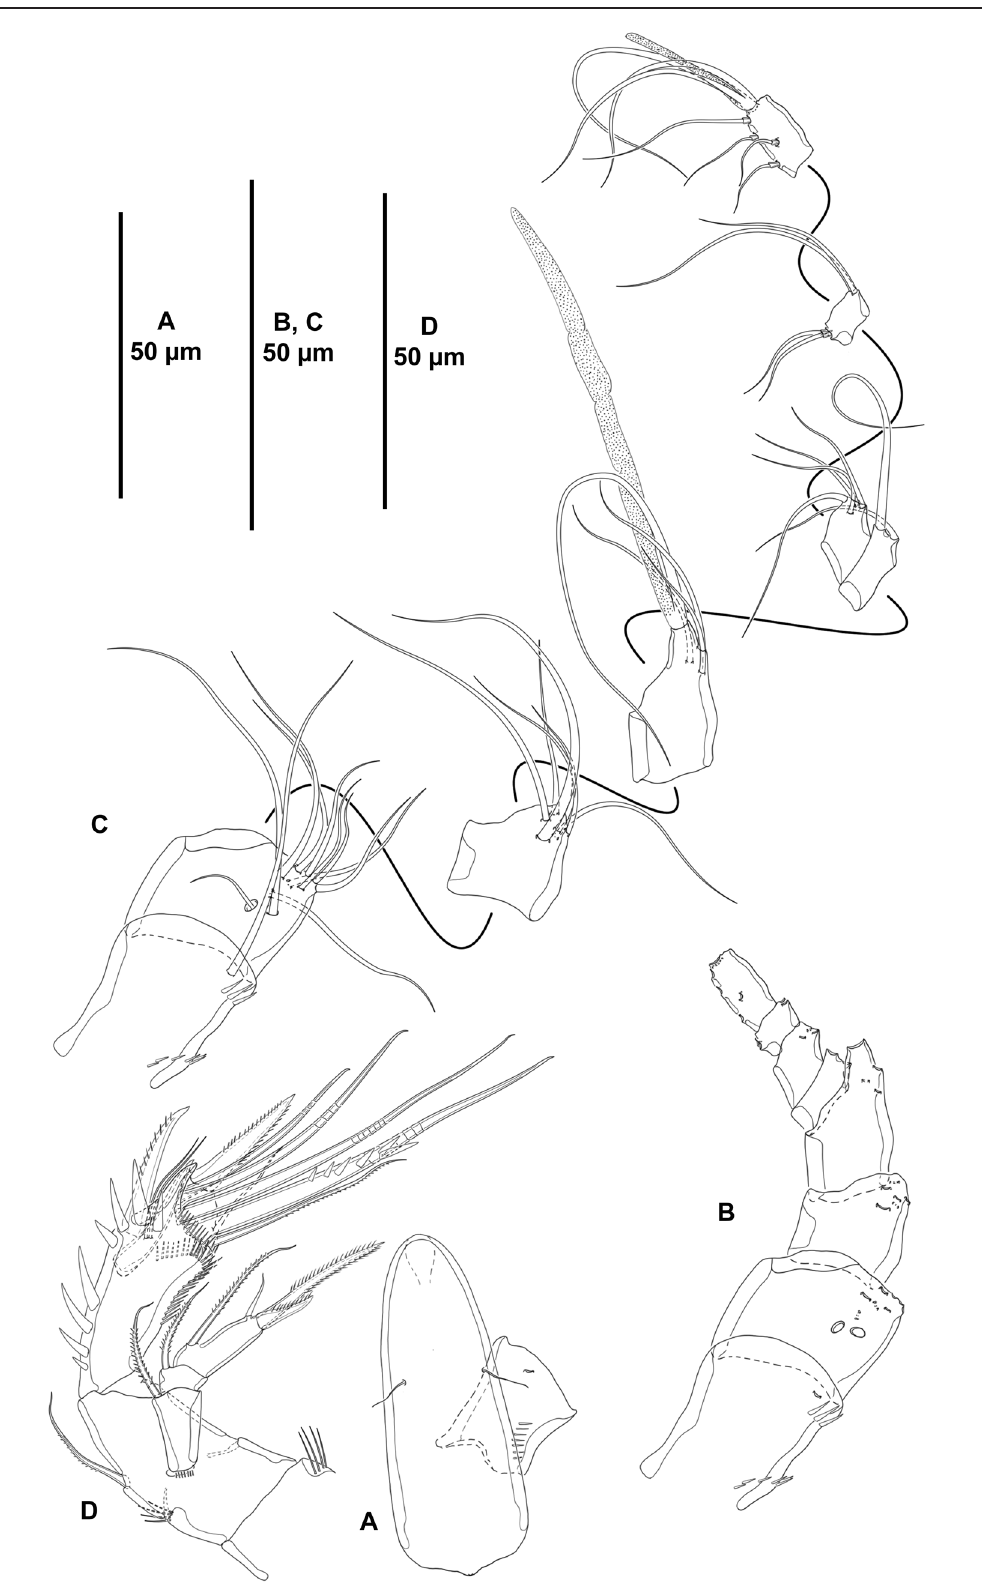
Fig. 13. Spinodiosaccus primus gen. et sp. nov., paratype, ♀ (ICML-EMUCOP-180119-64). A . Rostrum, dorsal view. B . Antennule (armature omitted for simplicity). C . Antennule showing armature. D .